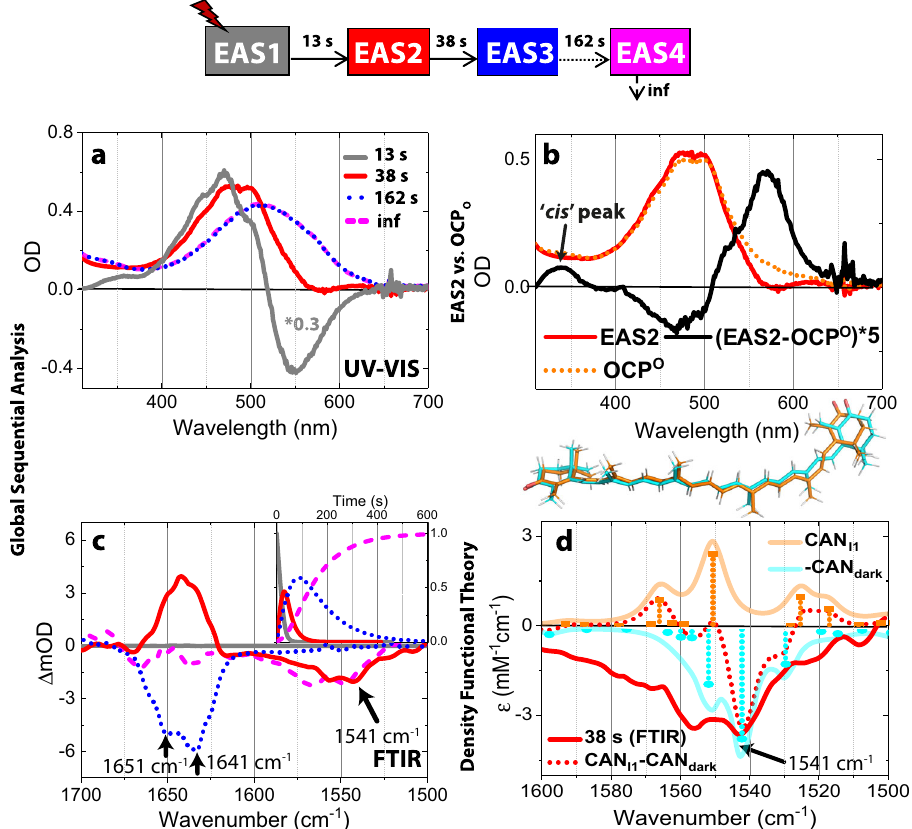
Fig. 8 | Spectroscopic evidence for bicycle pedal isomerization in OCP in solution. Results of the simultaneous global fi t of UV – VIS ( a ) and FTIR ( c ) data upon 10min of illumination. The kinetic model used for the fi t is shown on top of the panel with the respective lifetime for each transition between intermediates. The same colour code is used for the corresponding EAS components in panels ( a and c ).Refer to the maintext for anexplanation ofthe relationshipbetween the resolved EAS and the illuminated structural intermediates I1 – I4 (Figs. 1c, 6). a UV – VIS EAS. For EAS1 spectrum multiplication a factor of 0.3 was used. b EAS2 componentwascomparedtotheoriginalOCP O spectrum. c FTIREAS(inD 2 O);FTIR